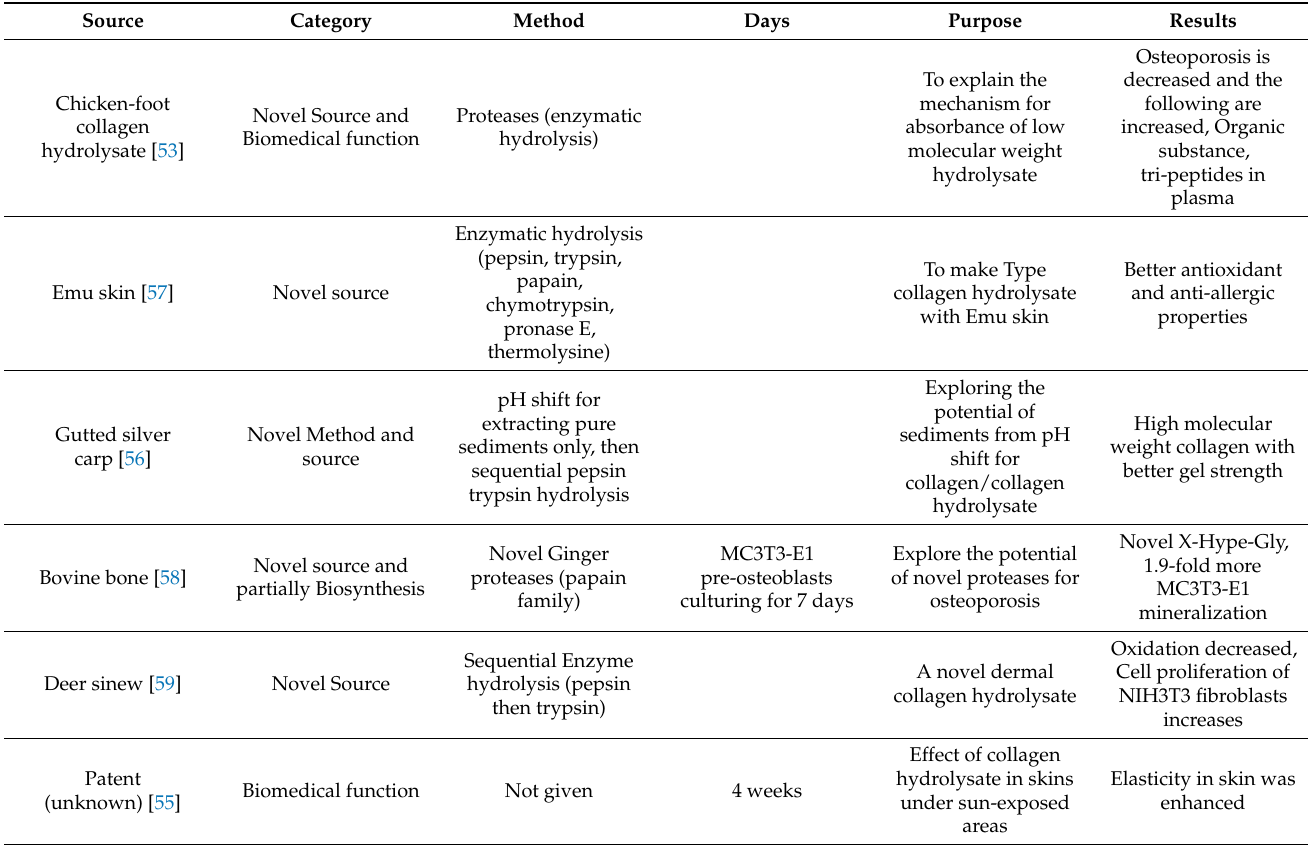
Table 2. Examples for Type I collagen or collagen